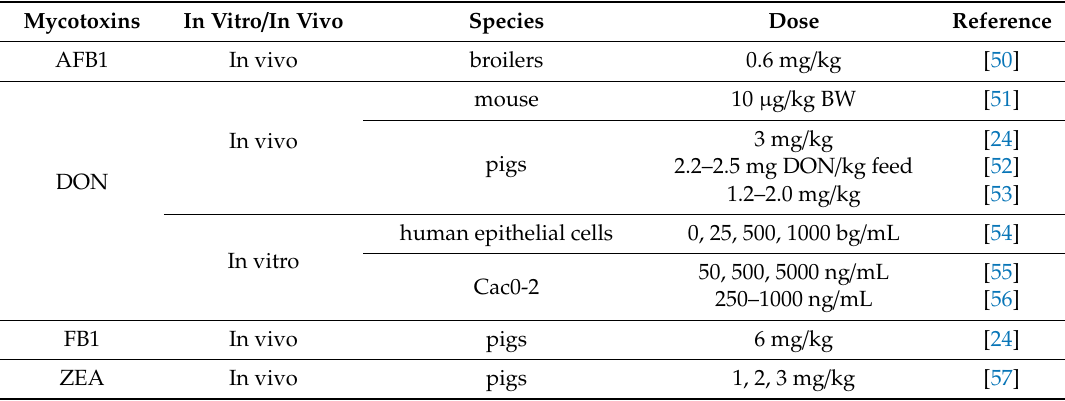
Table 4. In vitro and in vivo studies on the e ff ects of di ff erent mycotoxins on intestinal mucosal immune barriers in di ff erent